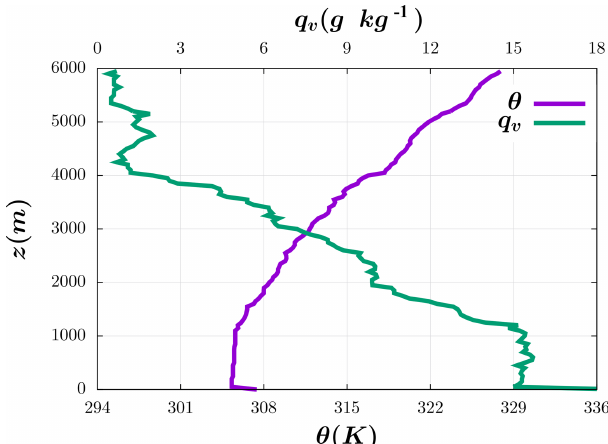
Figure 1. Vertical profiles employed as initial conditions in the sim-